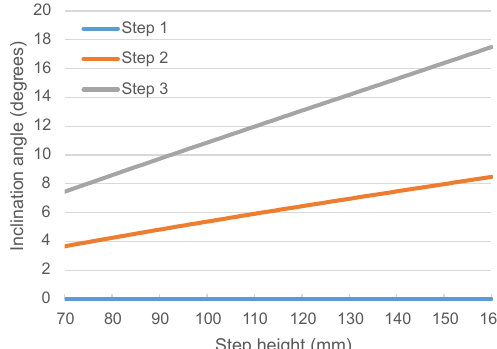
Figure 9. Variation of inclination angle of the robot with a change in height of a step at three initial steps of the stair during the operation of climbing up the stairs. The three plots, step 1, step 2 and step 3, represent the variation of inclination angle when the front wheel is at the first, second and third step of the stair, respectively.